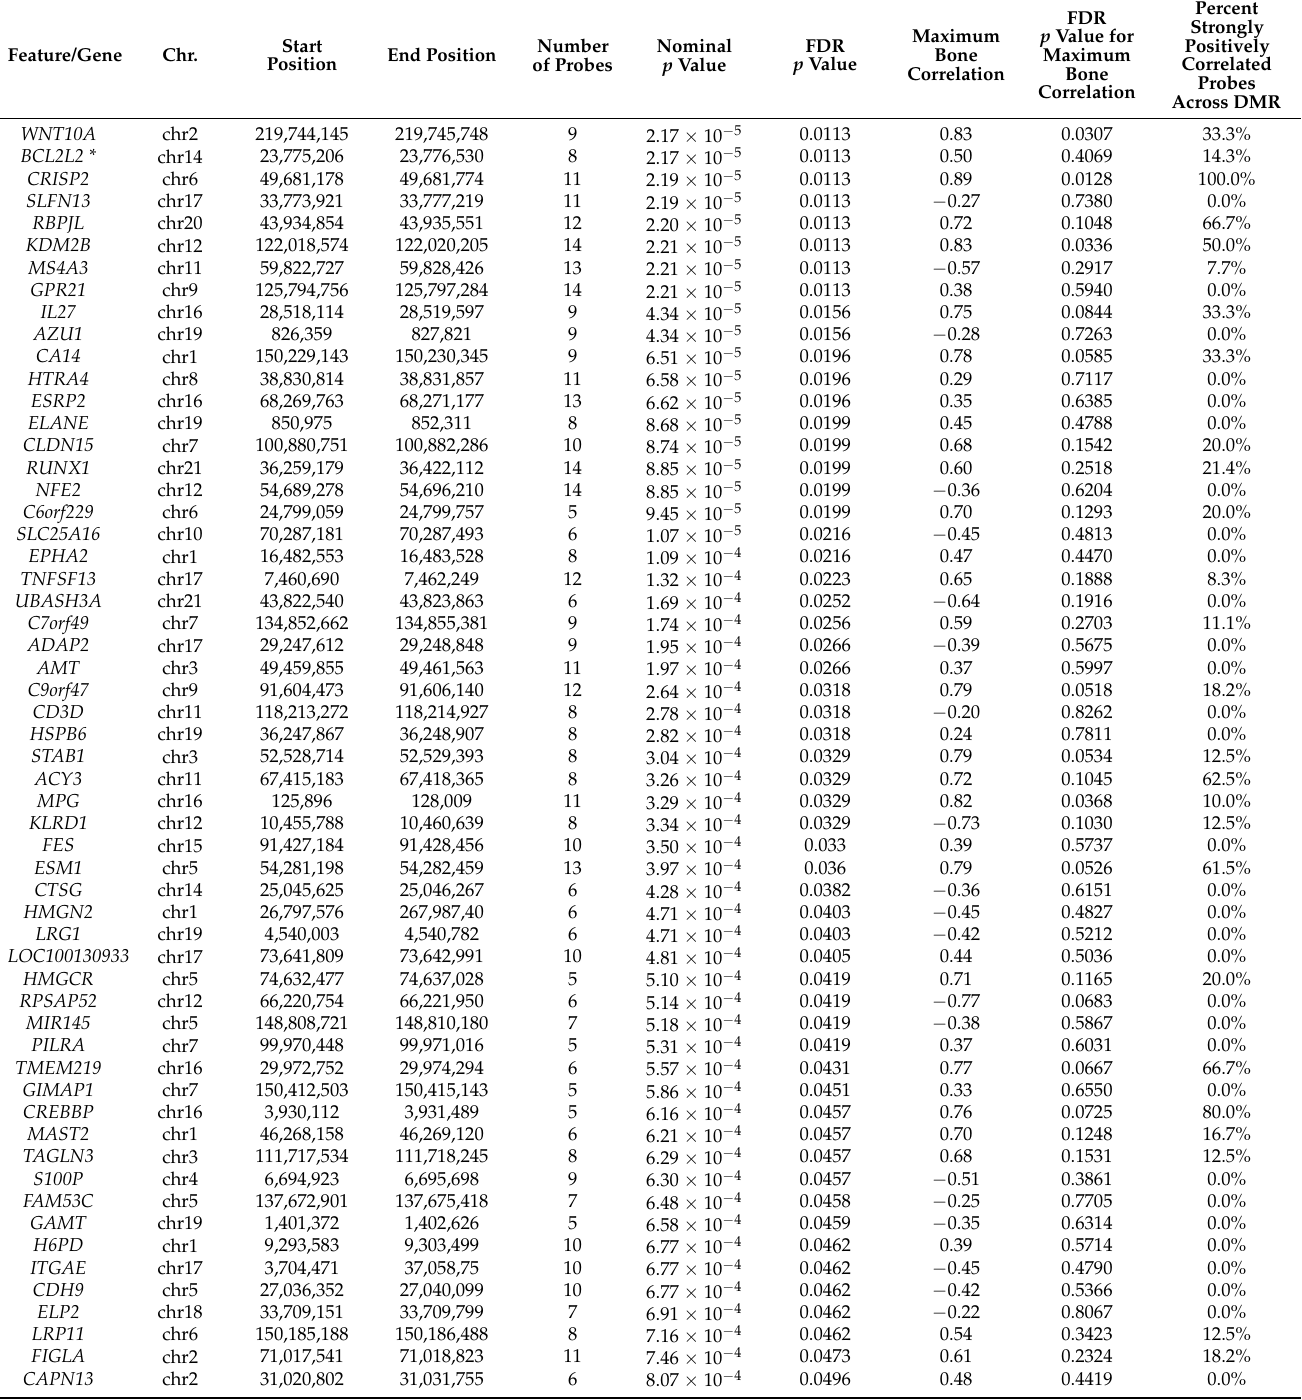
Table A2. Analysis of Discordant Curve Severity in Twin Pairs Identified 57 Differentially Methylated Regions where Hyper- or Hypo-methylation was Consistent Across all Probes in the Region.